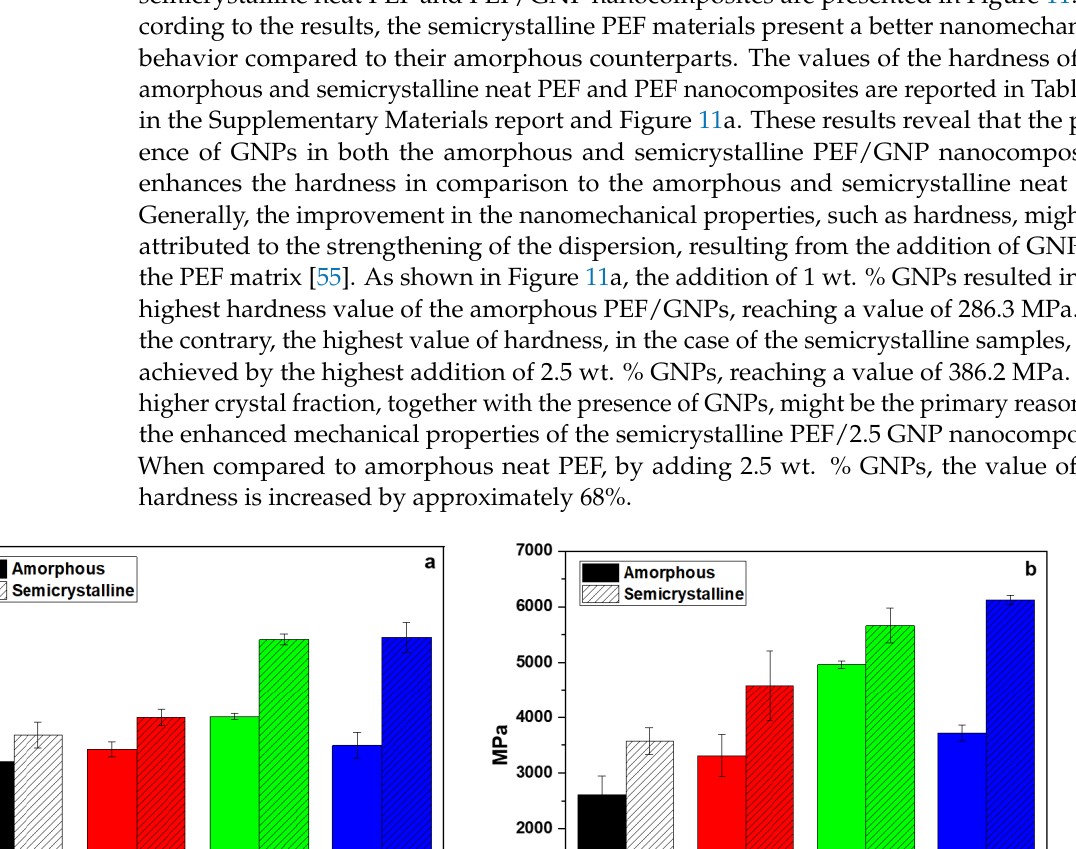
Figure 10. Comparison of the representative load – depth nanoindentation curves of the amorphous and semicrystalline neat PEF and PEF/GNP nanocomposites.